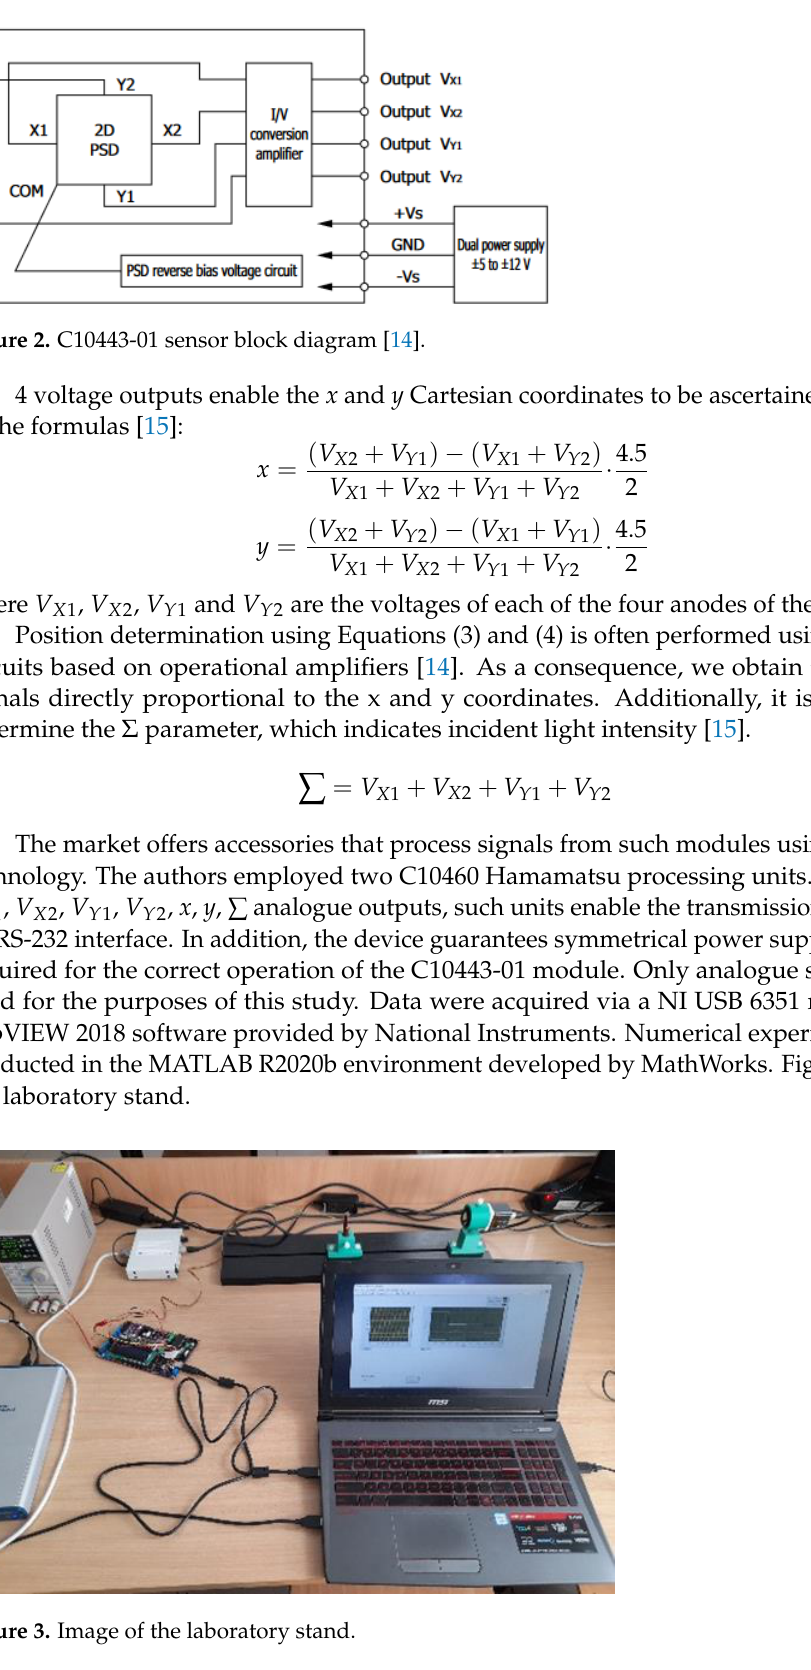
Figure 3. Image of the laboratory stand.